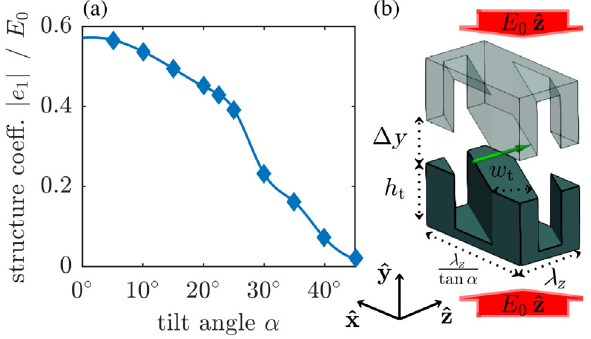
FIG. 3. Lattice design and beam trajectory (amplitude not to FIG. 2. CST STUDIO simulation [27] for the structure coefficient scale) of a phase-synchronous DLA undulator for a ˆ z polarized j e 1 ð α Þj of a silica grating at different tilt angles α for a ˆ z polarized drive-laser with amplitude E 0 . Each segment consisting of n ¼ 2 drive-laser with amplitude E 0 in (a). The grating design in tilted DLA cells imposes a constant deflection force on the beam. 0 . 6 λ (b) uses a tooth width of w , a tooth height of t ¼ g = 2 shifts the phase by Δ φ ¼ π which A subsequent drift space λ z flips the direction of the force.